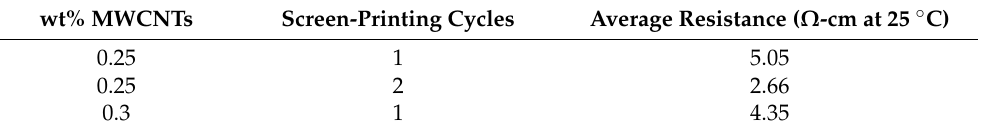
Table 1. PTC-SHE resistance according to MWCNT contents and number of screen-printing